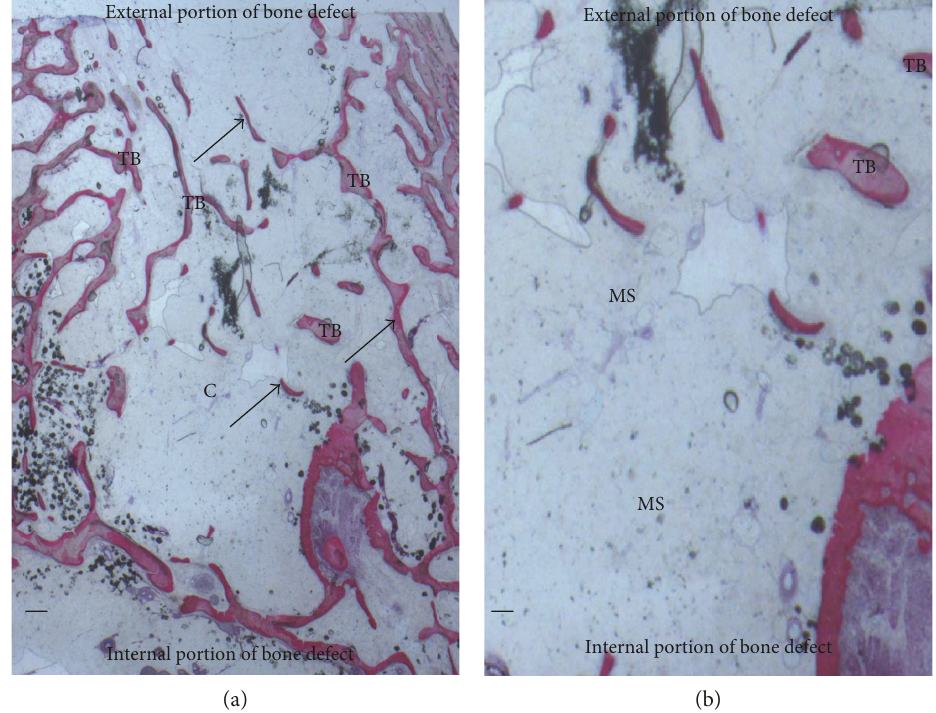
Figure 4: (a) Control group. Trabecular bone (TB) was present in the central portion of the bone defects (c). New bone (arrows) extended to the basal third from the margin of the bone defect. Acid fuchsin and toluidine blue. Bar=200 μ . (b) Previous image at higher magni fi cation. Isolated trabecular bone (TB was seen throughout the medullary space (MS). Acid fuchsin and toluidine blue. Bar =200 μ